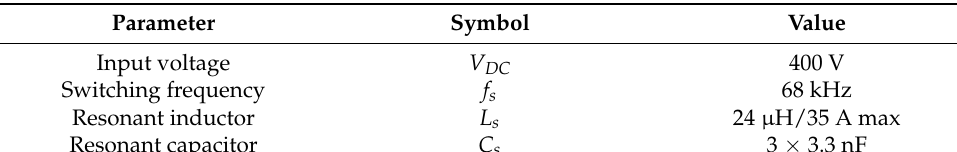
Table 2. Selected parameters of resonant converter.